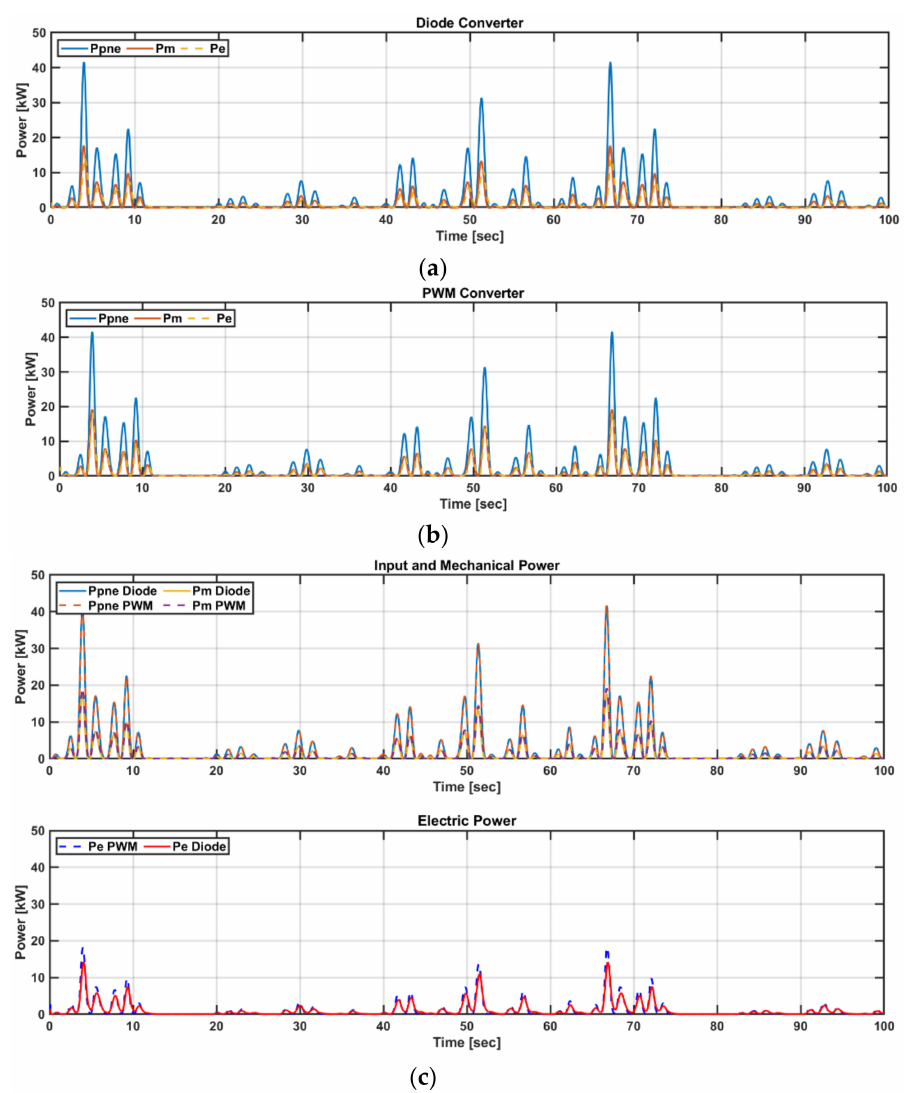
Figure 22. Power generation result of the PTO system in an integrated simulation under irregular wave conditions ( v t = 0~30 m / s and Tp = 4.75 s): ( a ) Diode converter; ( b ) PWM converter; ( c ) Comparison of power generation performance according to